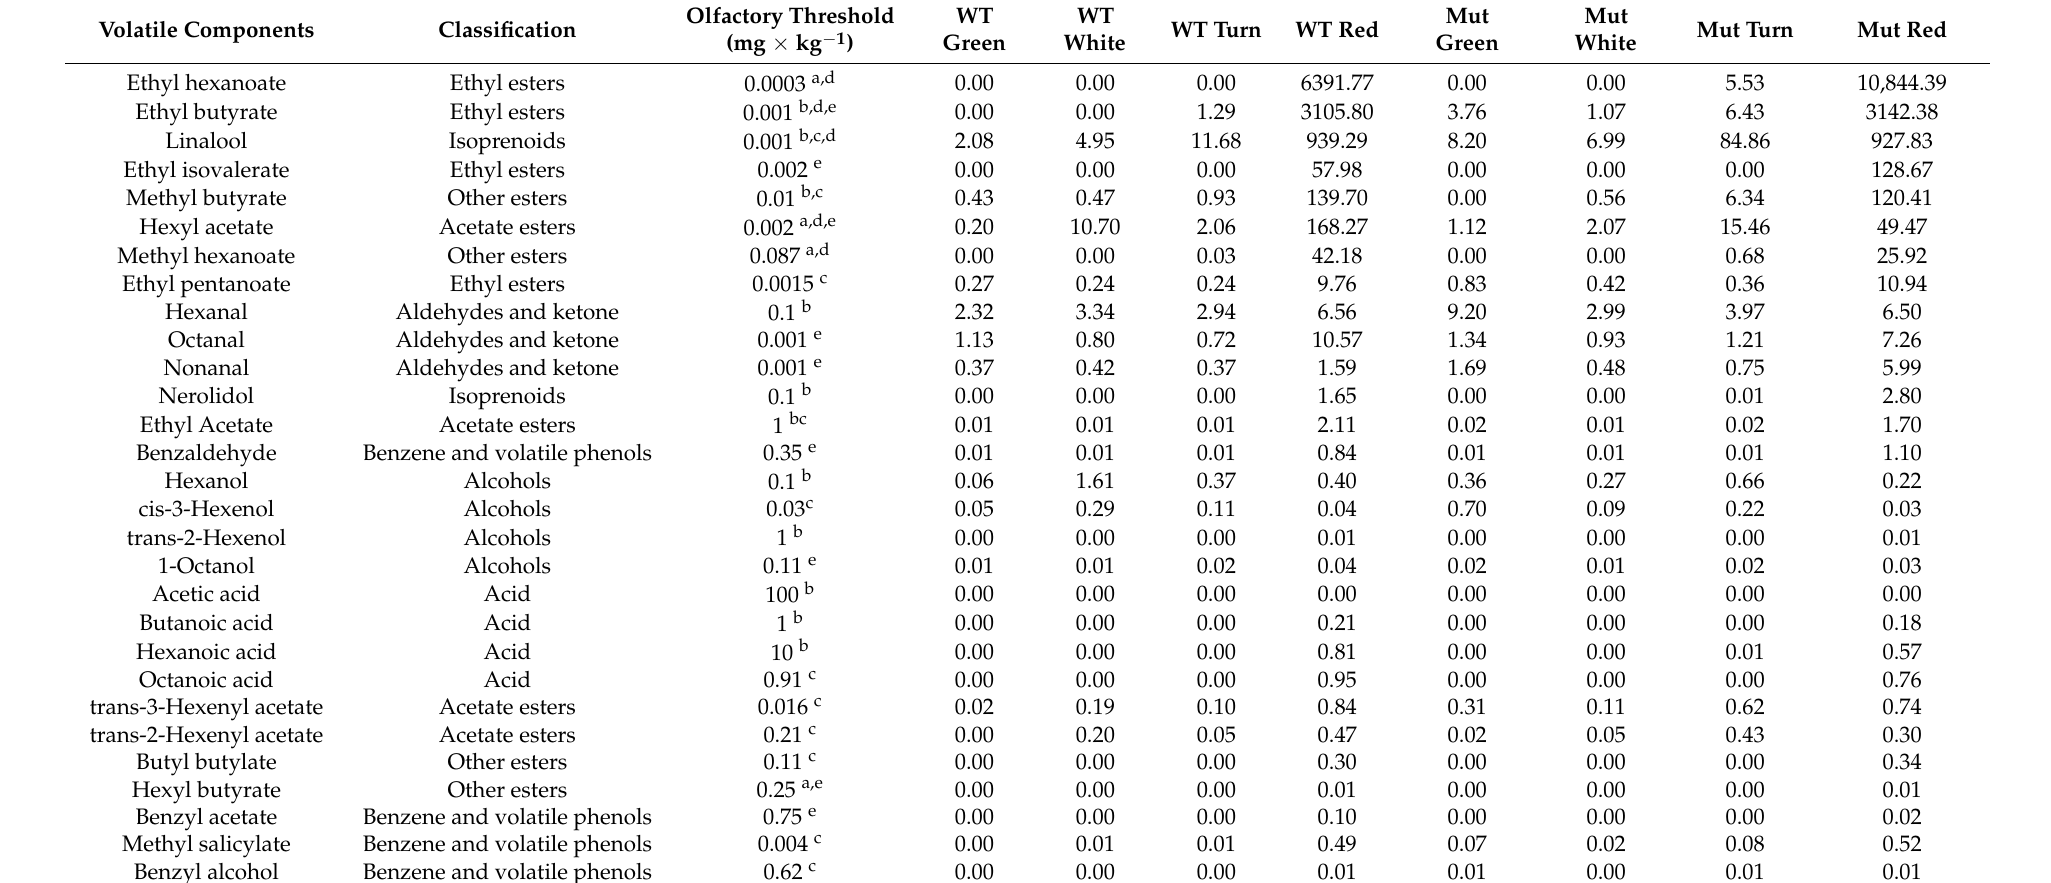
Table 1. The odor activity values (OAVs) of partial volatile components in ‘Sachinoka’ strawberry and its somaclonal mutant